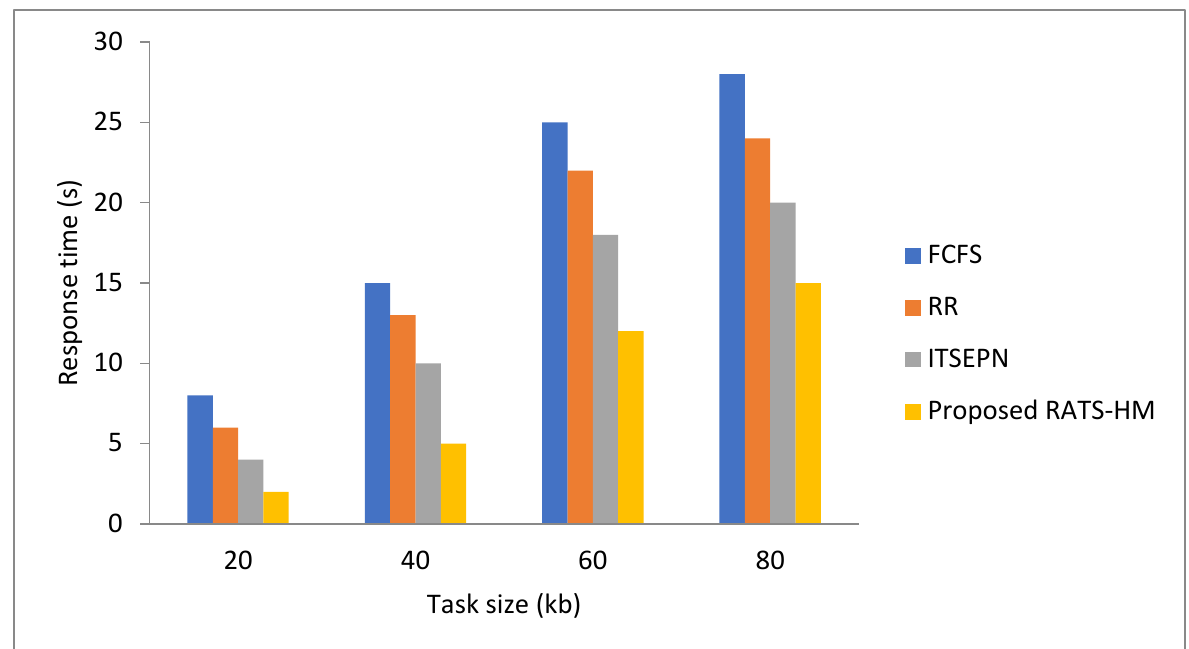
Figure 3. Comparison of responses time.